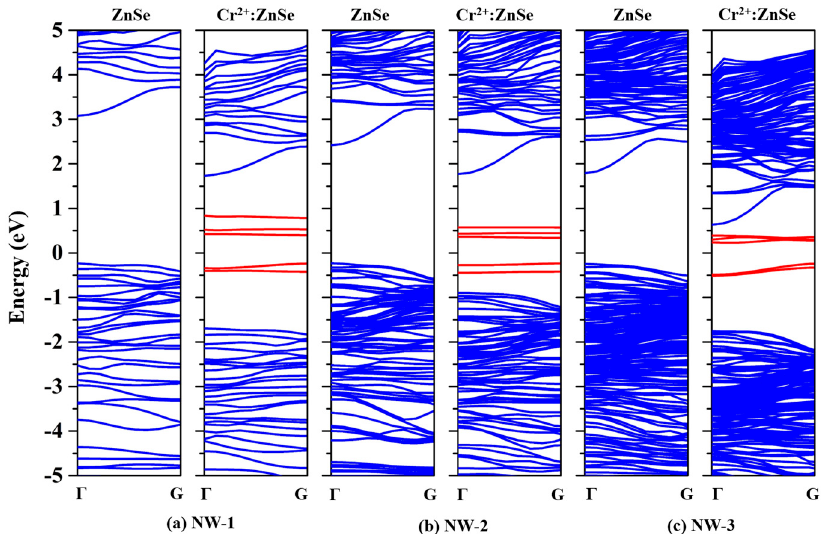
Figure 2. The band structure of ZnSe and Cr 2+ :ZnSe NWs in different sizes. The lines in blue present the intrinsic bands of ZnSe NWs, and the red lines present the impurity bands introduced by Cr atom